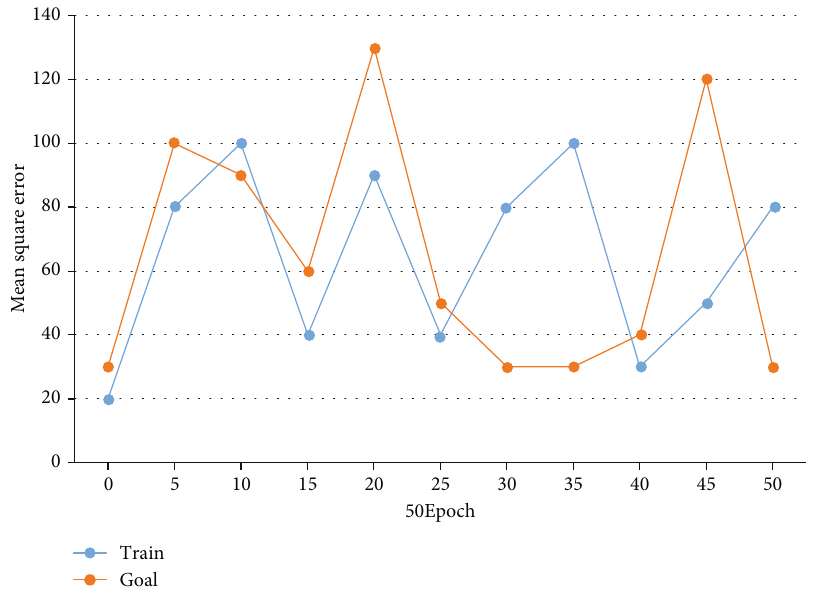
Figure 4: Mean square deviation of network structure on [5, 10].